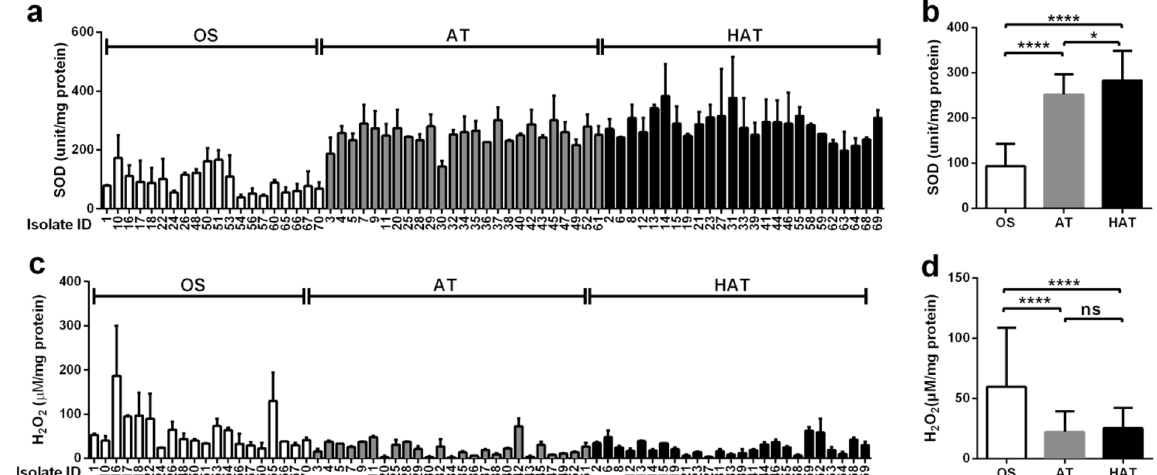
Figure 2. Superoxide dismutase (SOD) and catalase activities in C . jejuni isolates from retail chicken. SOD activities in 70 strains of C . jejuni ( a ) and the average of SOD activities in OS, AT, and HAT strains ( b ). Catalase activities in 70 strains of C . jejuni ( c ) and the average of catalase activities in OS, AT, and HAT strains ( d ). The results show the means and standard deviations of a single experiment with triplicate samples, and the experiment was repeated three times. Two-way ANOVA was used for statistical analysis. ns: not significant, * P < 0.05, **** P <